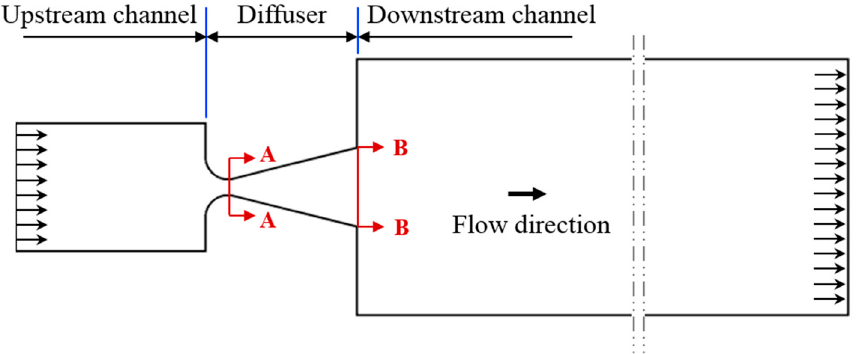
Figure 1. Top view of the computational domain.